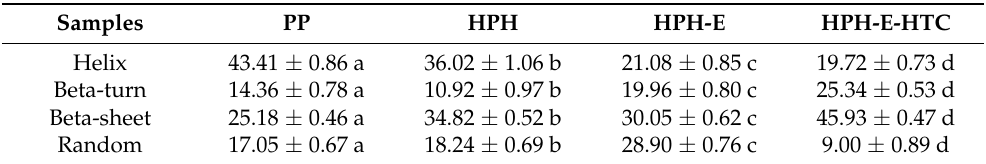
Table 3. The secondary structure of peanut protein (PP), high pressure homogenized protein (HPH), high pressure homogenized and enzyme (E) treated protein (HPH-E), and HPH-E-hydrothermally cooked (HPH-E-HTC)